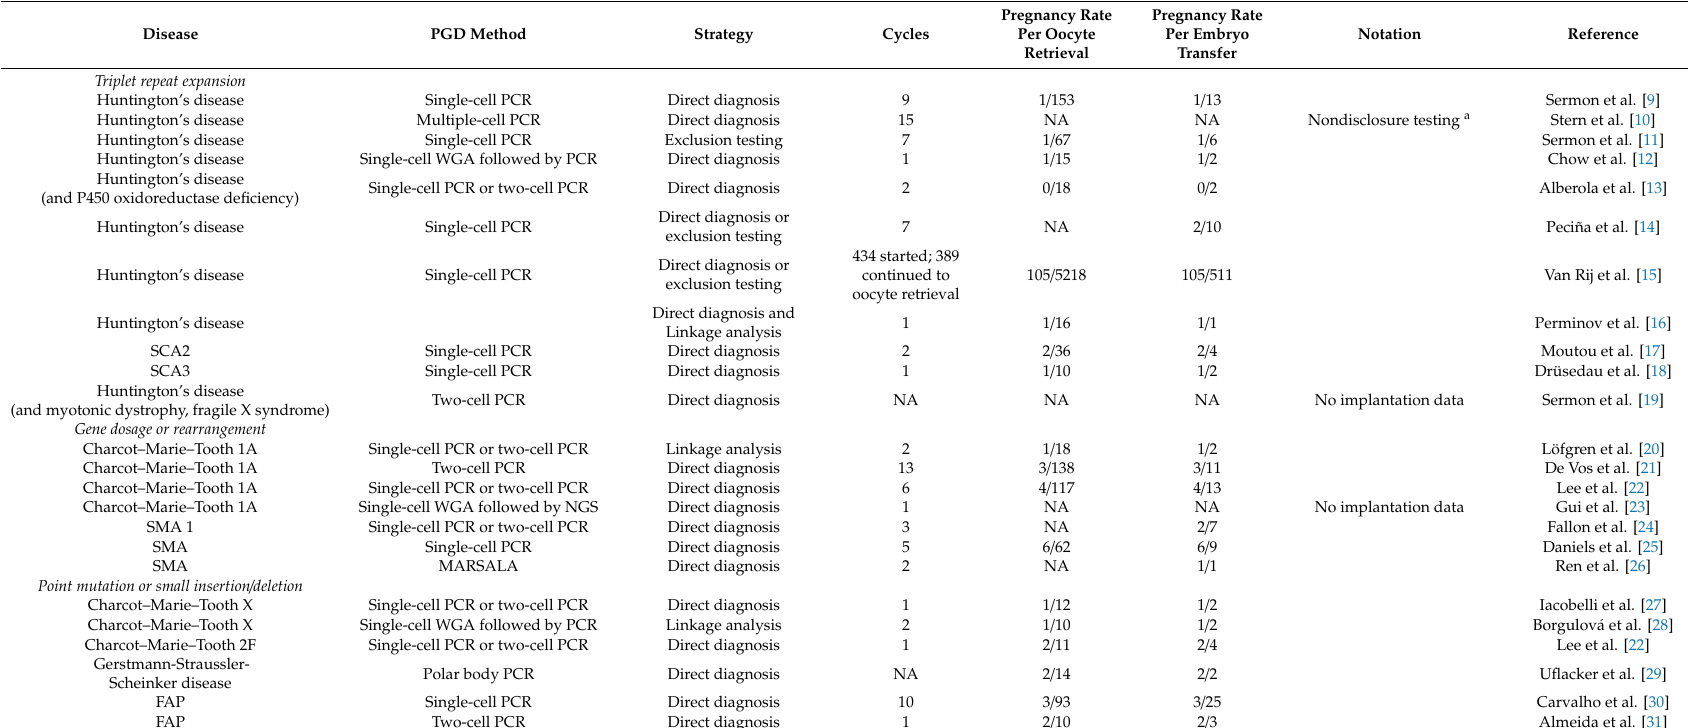
Table 2. Methodologies used for the PGD of neurodegenerative